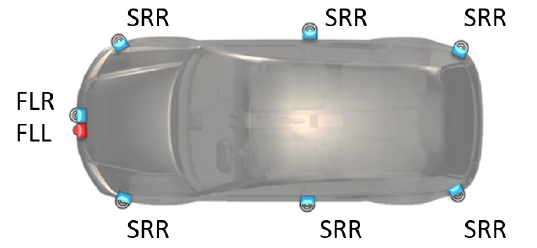
Figure 5. Sensor suite on the vehicle model (SRR—Short Range Radar; FLR— Forward Looking Radar; FLL—Forward Looking Lidar).